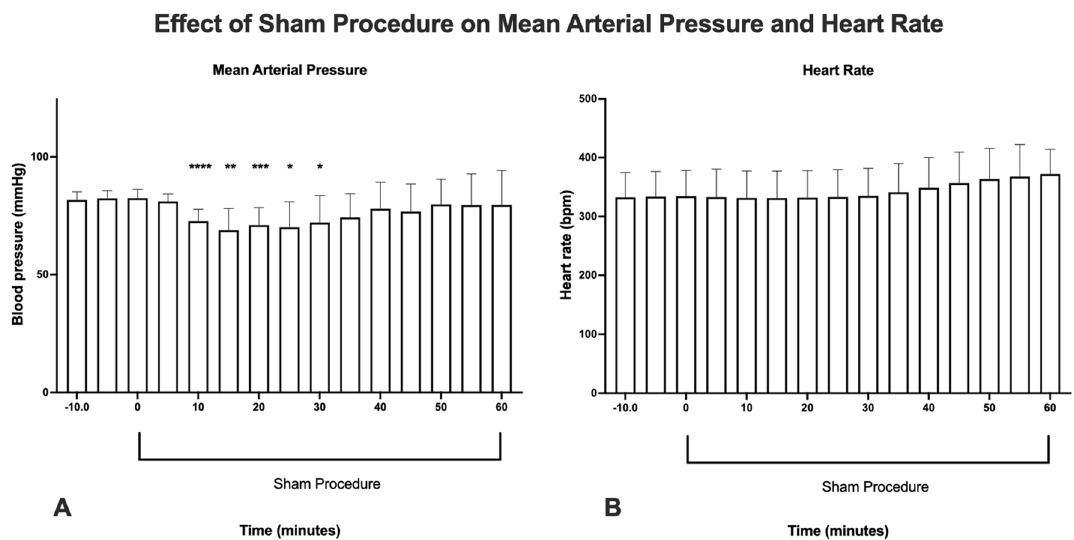
Figure 5. Effect of a 1-h sham procedure on: ( A ) mean arterial pressure and ( B ) heart rate. Sham was started at (timepoint 0 min) and recorded continuously during the experiment (n = 9 animals; mixed-effect analysis with Dunnet correction for multiple comparisons. (*): p < 0.05, (**): p < 0.01), (***): p < 0.001 (****): p < 0.0001 (image produced by B(GH) Janssen using; Prism 9 for macOS (Version 9.2.0 (283), GraphPad Software, San Diego, California USA, http:// www. graph pad. com).